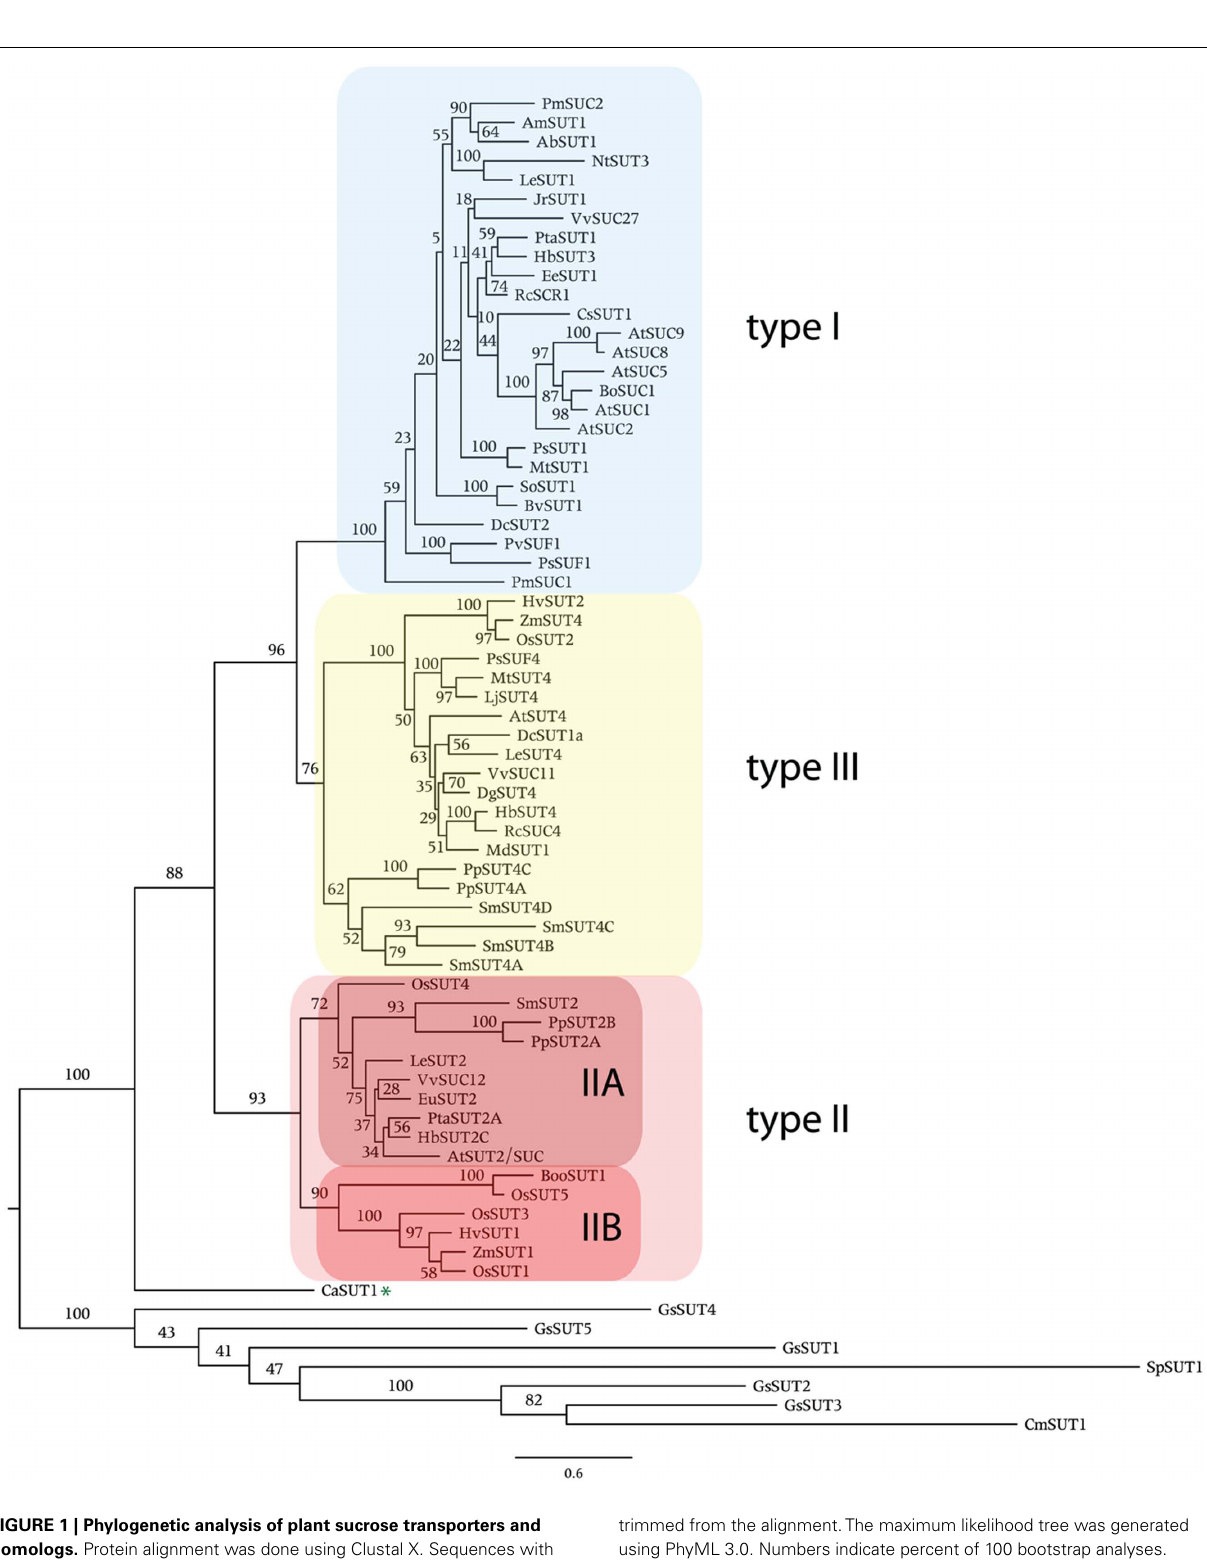
trimmed from the alignment.The maximum likelihood tree was generated using PhyML 3.0. Numbers indicate percent of 100 bootstrap analyses. Asterisk indicates the single charophyte SUT sequence, CaSUT1, from Chlorokybus atmosphyticus